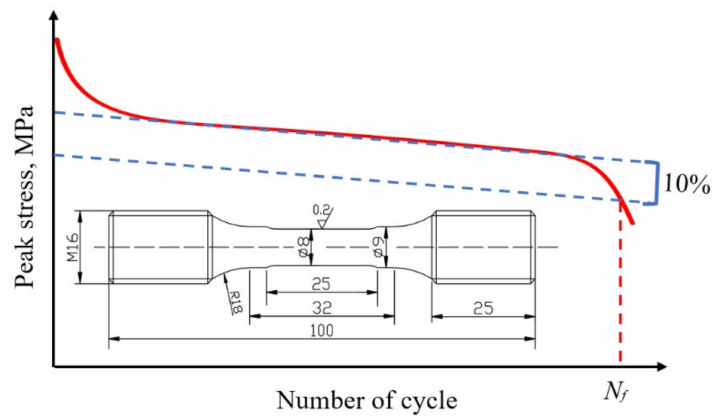
Figure 2. Geometry of specimen (inset figure) and determination of fatigue life ( N f ). Table 2. Fatigue–creep tests performed, test parameters prescribed and fatigue life determined. Test